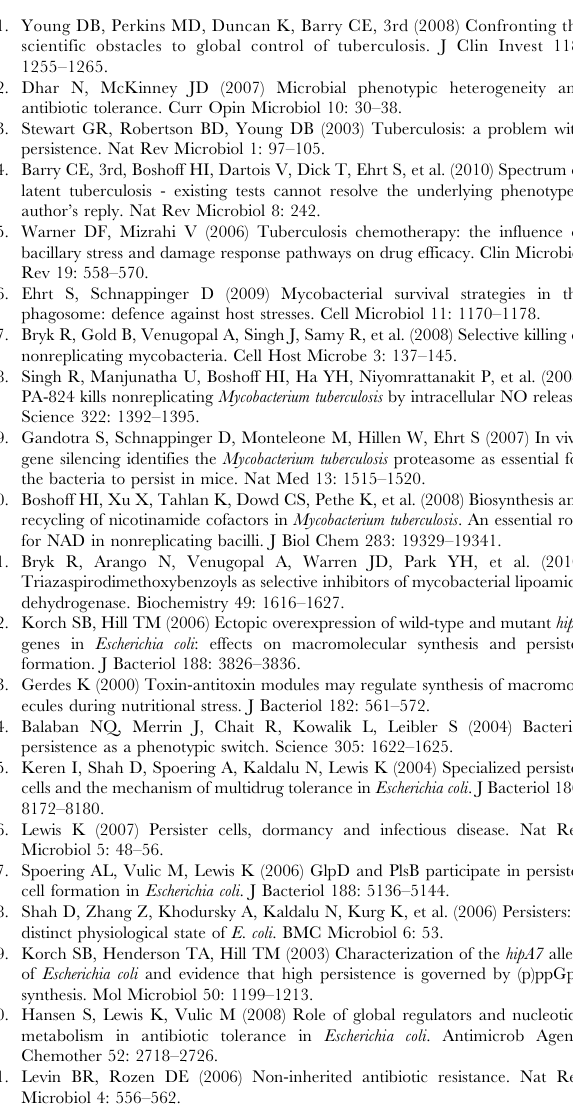
Table S5 Oligonucleotides used to create knockout vectors for allelic exchange mutagenesis. Table S6 Oligonucleotides used for expression vector construc- tion, yeast two-hybrid (Y2H) vector construction and